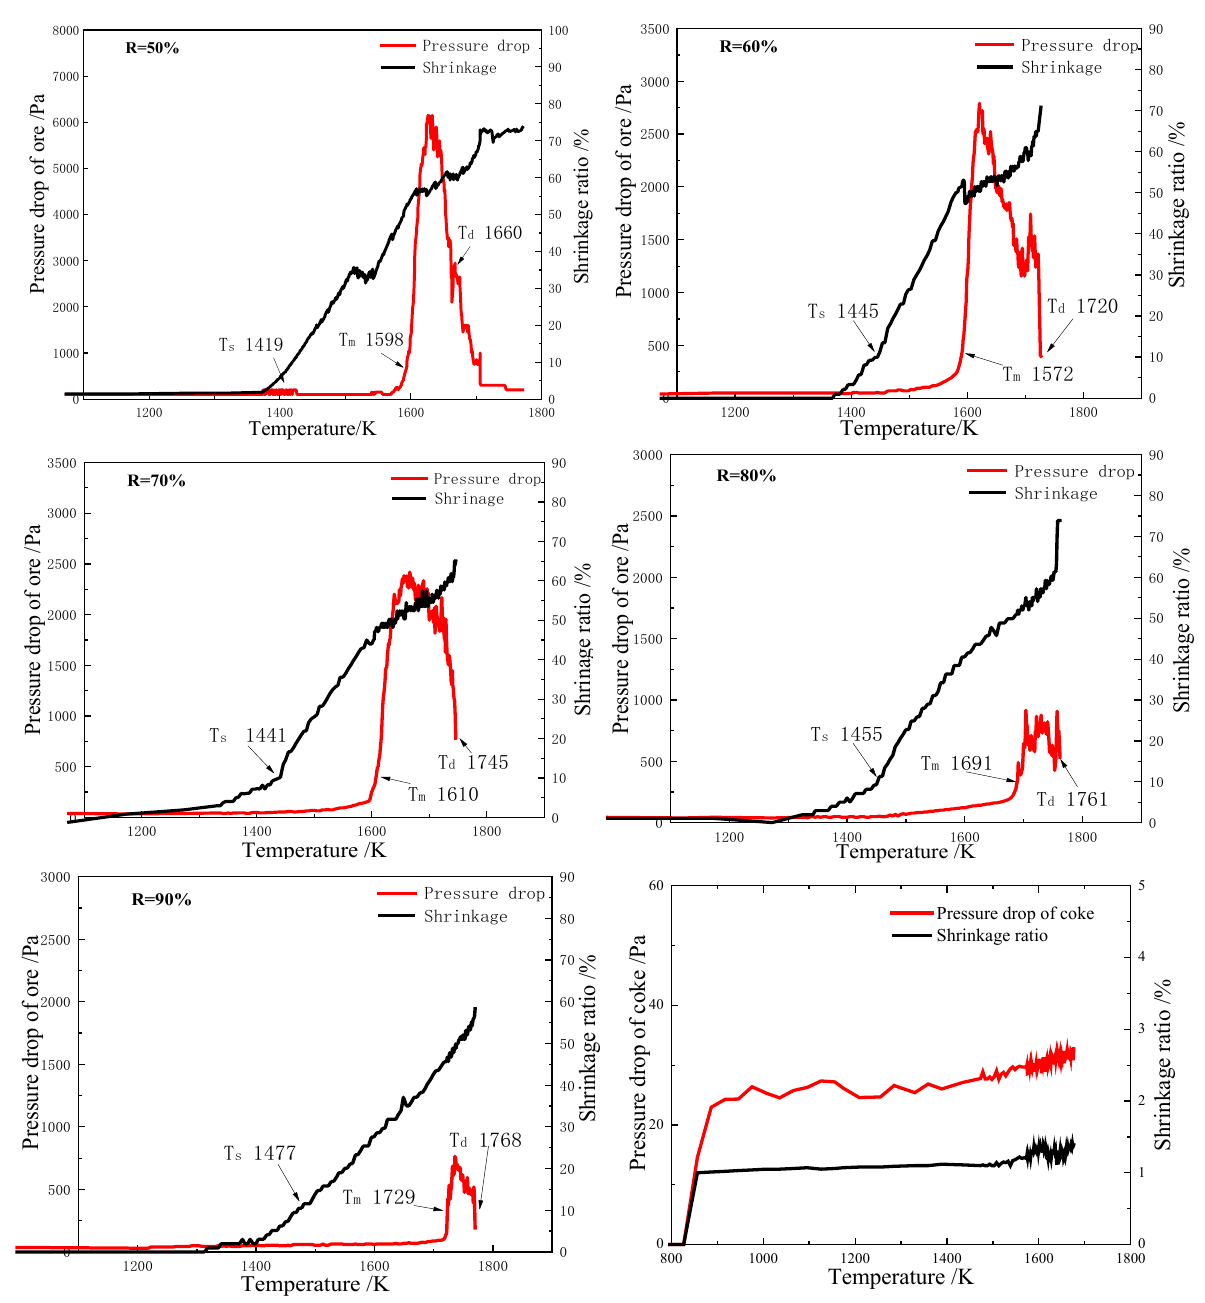
Figure 1. Pressure drop and coke layer shrinkage ratio, respectively, of the ore layer with prereduction rates of 50%, 60%, 70%, 80%, and 90%. T s is temperature point at which softening starts (10% shrinkage); T m is the temperature value when melting starts (a 490 Pa pressure drop); T d is the temperature when the dripping begins (the first liquid metal appears). The trend of the temperature-pressure-drop curve of the softening-and-melting ex- periment was very consistent with the results in the literature [9,10], and the values were also very close to each other. The curve in Figure 1 shows that the pressure drop and the shrinkage of the coke layer did not change significantly. This explains why coke can play the roles of supporting the material column and maintaining the channel of the upward flow of gas and the downward flow of molten iron, especially in the high-temperature region in the middle and lower parts of